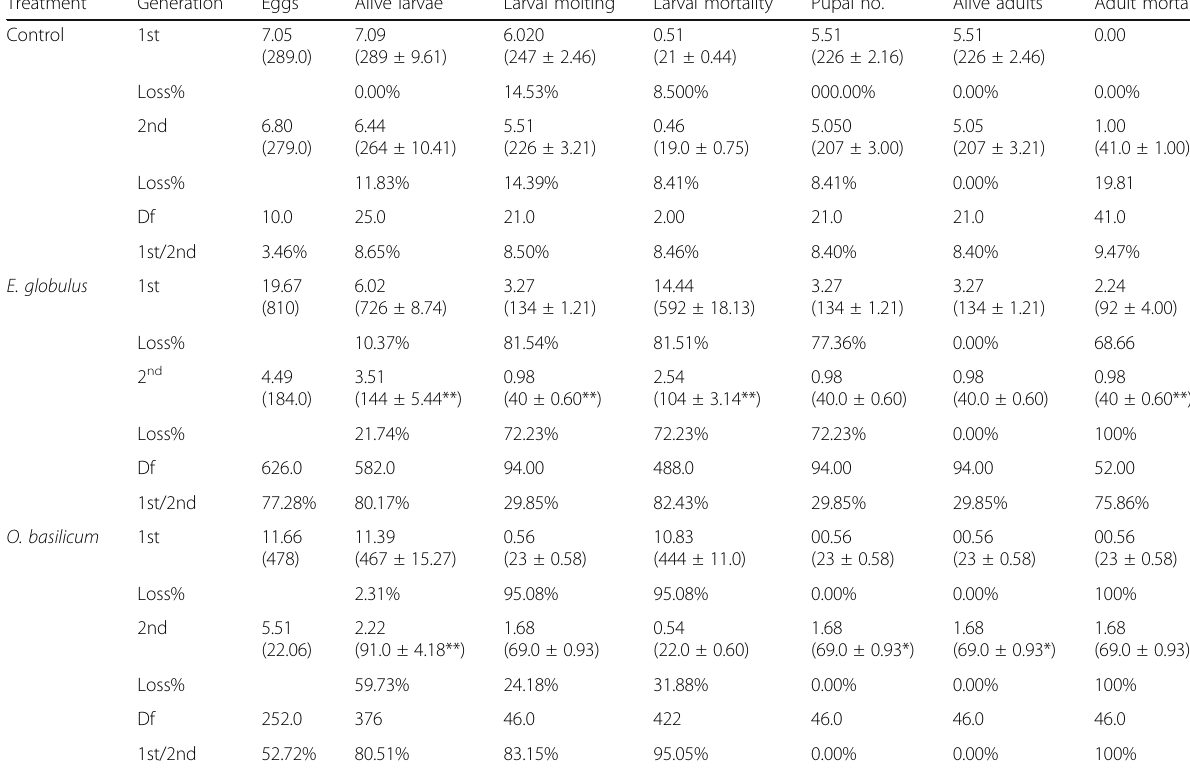
Table 1 Culex pipiens individual numbers under the effect of smokes of Eucalyptus globulus and Ocimum basilicum leaves for two generations